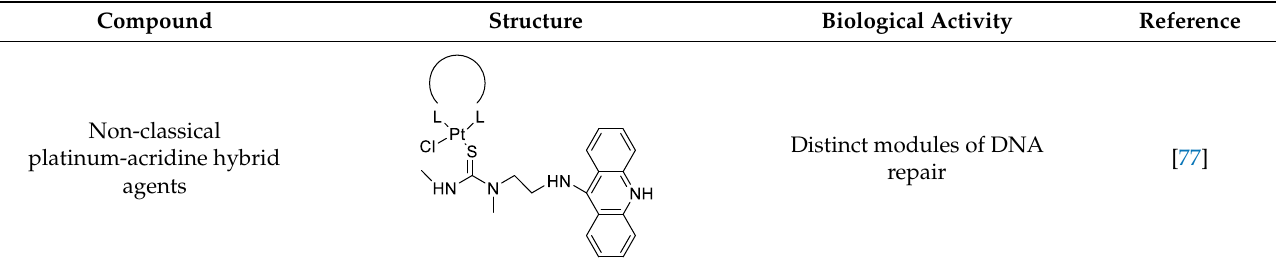
Figure 10. Schematic diagram of acridines with metal (platinum) complexes. Table 12. Platinum-acridine as an anti-tumour agent.